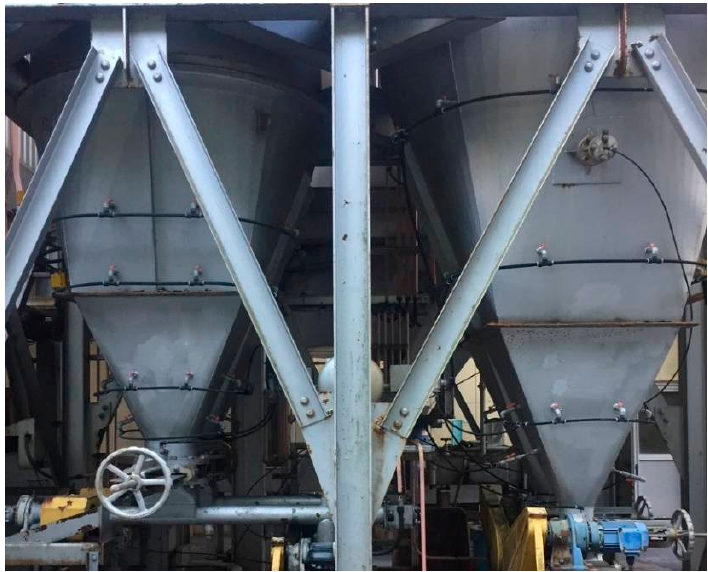
Figure 8. Silos for slaked lime in a municipal solid waste incineration facility.